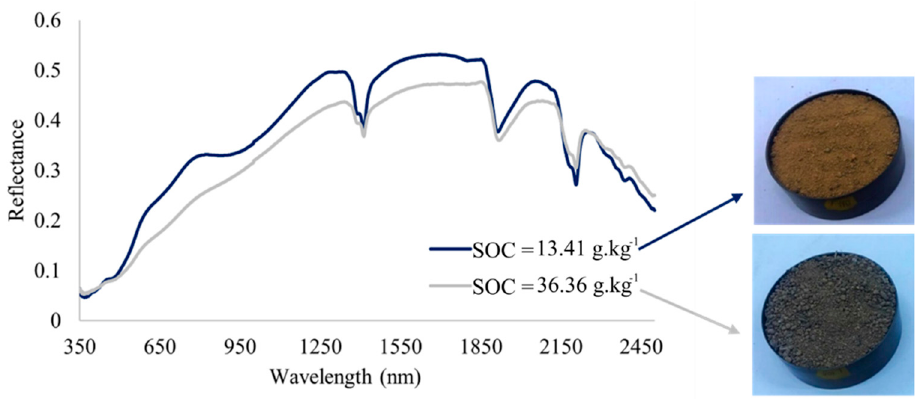
Figure 7. Full spectra of samples from A2 with different SOC content.